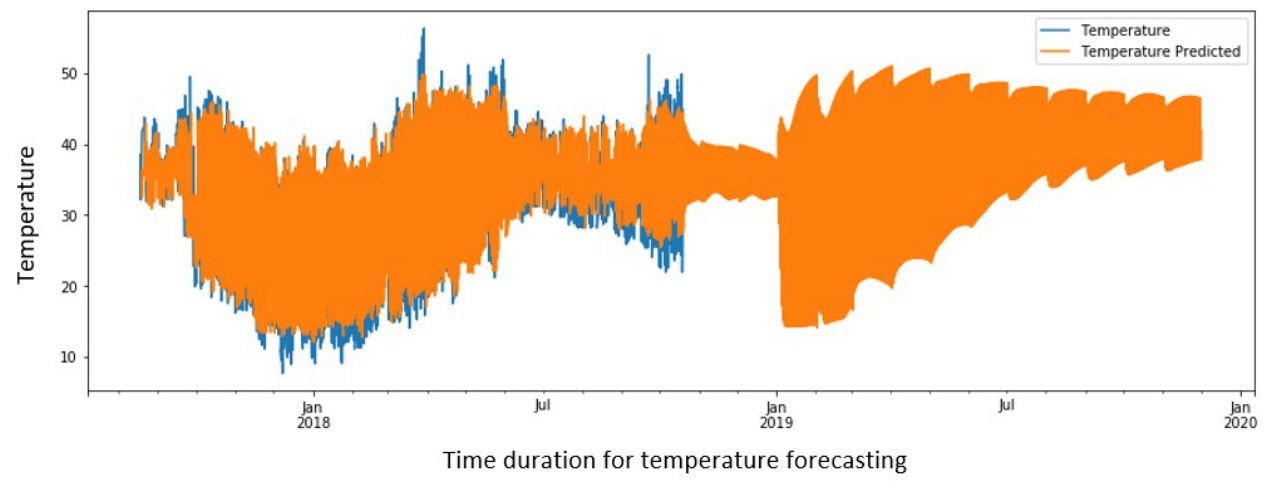
Figure 9. Forecasted readings of temperature.